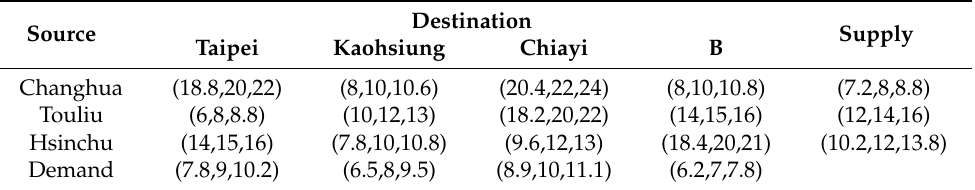
Table 1. Summary information of potential suppliers, demand and supply in 000 dozen bottles, transportation costs between centers in